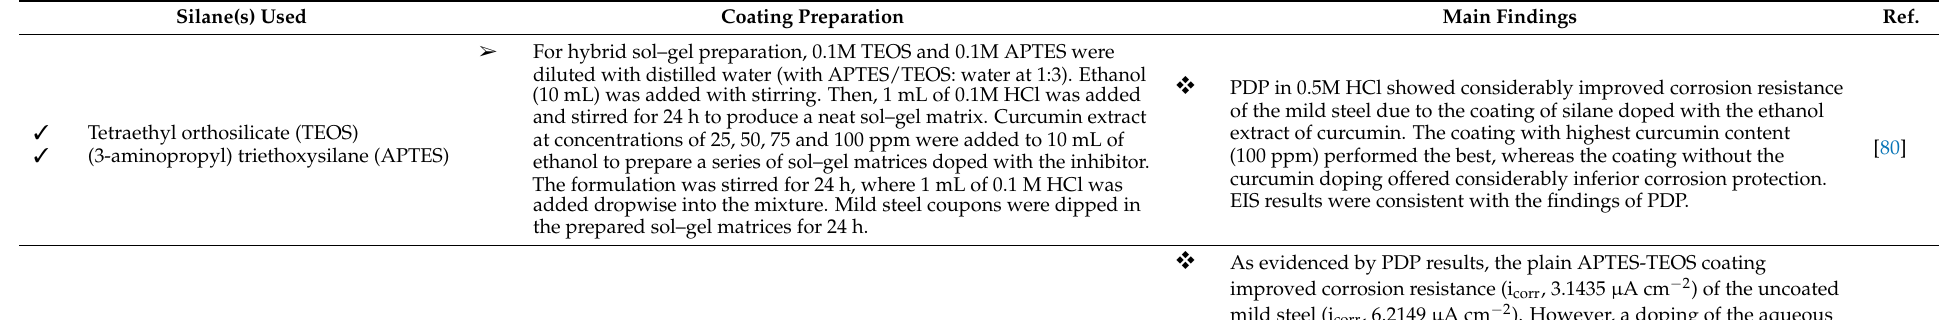
Table 1. Different approaches for improving silane coatings and the main findings, as reported in the literature.